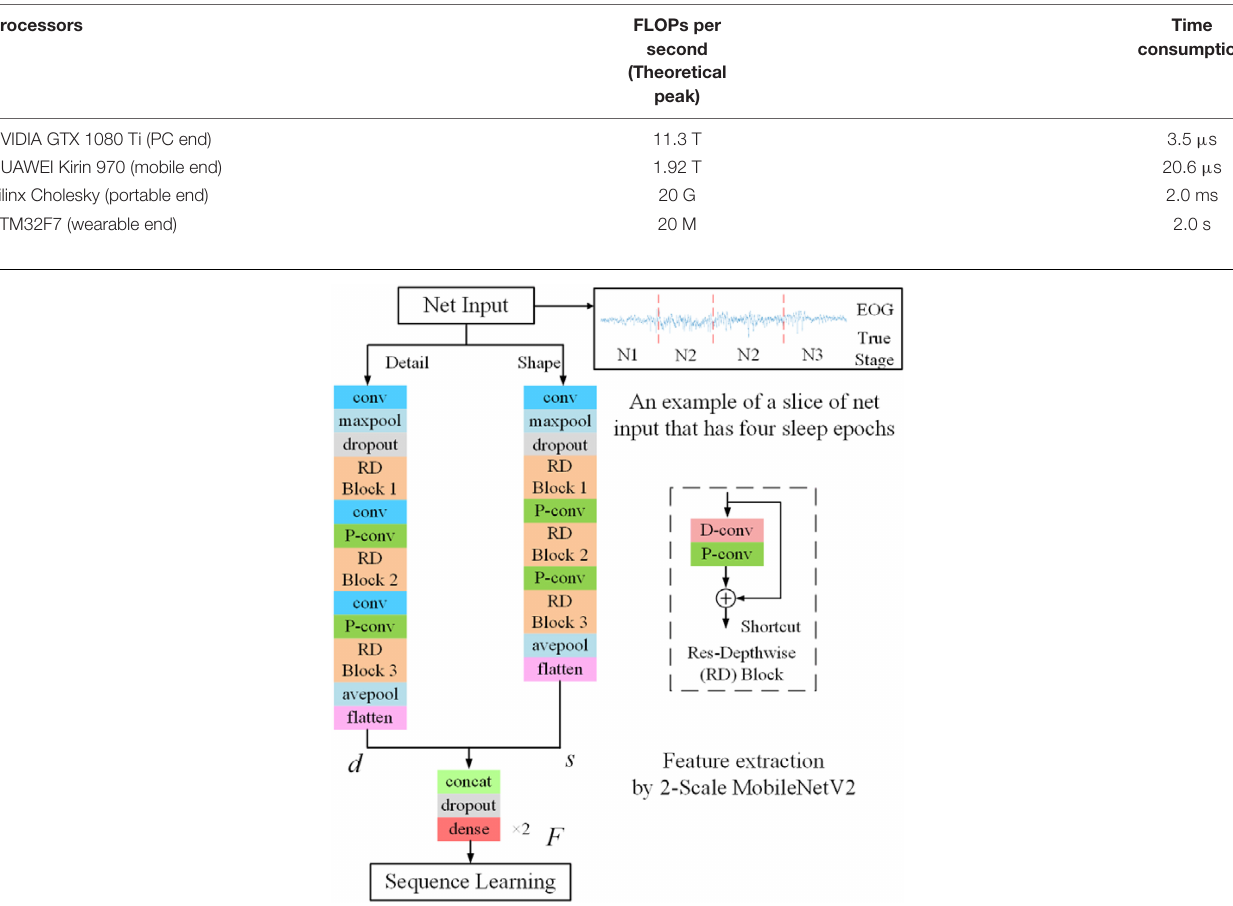
TABLE TA2 | FLOPs per second of the current mainstream processors and their time consumptions for running the proposed model.